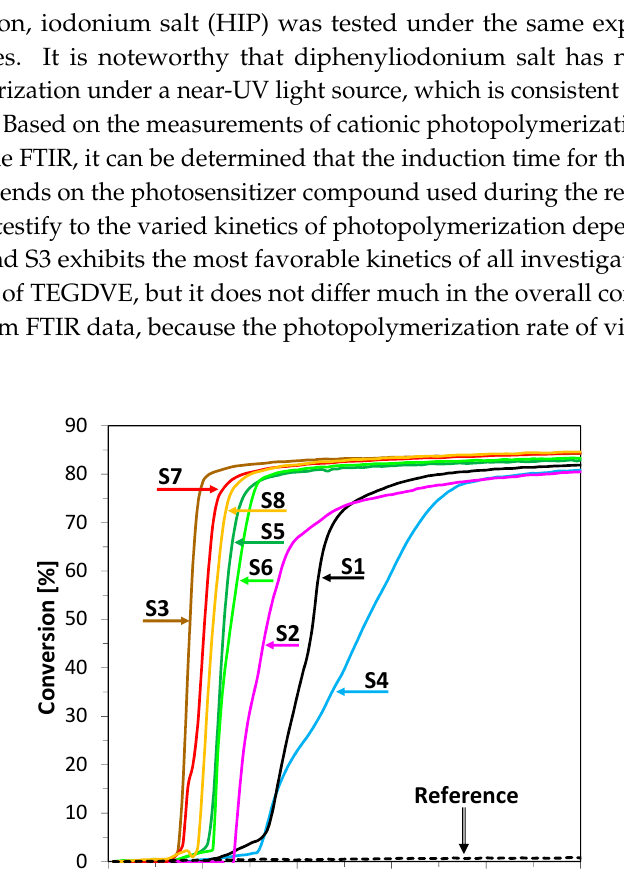
Figure 4. Comparison of absorption spectra of common cationic photoinitiators with emission spectra of 365 nm UV-A LED and visible LED at 405 nm.